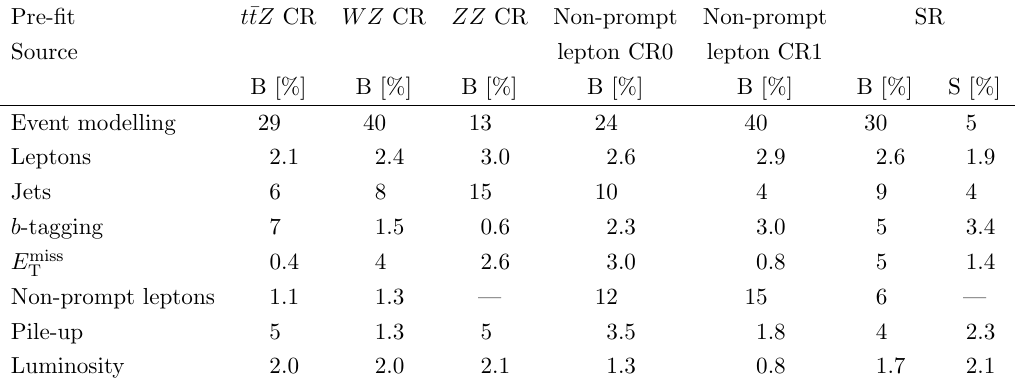
Table 6 . Summary of the relative impact of each type of uncertainty on the total background (B) yield in the background control regions and on the background and signal (S) yields in the signal region before the combined (cid:12)t under the background-only hypothesis.